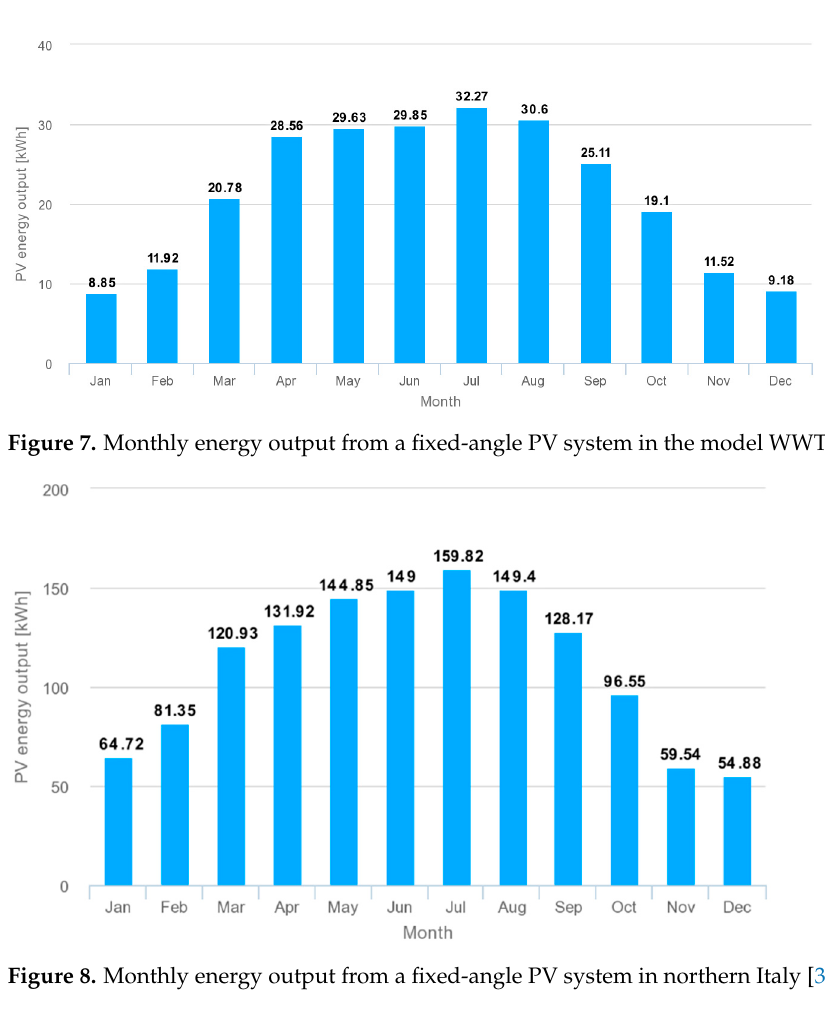
Figure 7. Monthly energy output from a fixed-angle PV system in the model WWTP location [35].